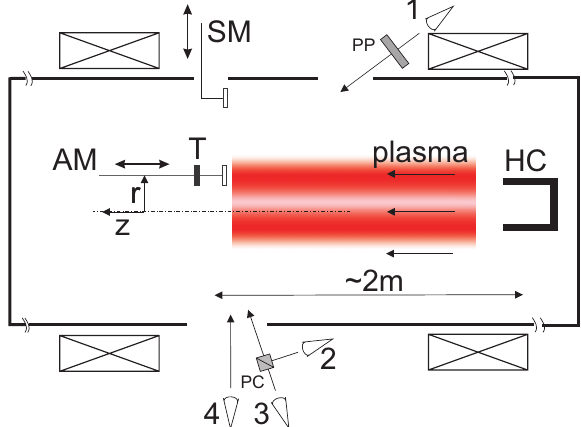
Figure 4. Top view of the optical emission measurements at the linear plasma PSI-2 [18]. Plasma is generated at the hollow cathode HC, and the target T is positioned in one of the maxima of the plasma profile using either the axial manipulator AM or the side manipulator SM. Line-of-Sight 1 observes the target at 35 ◦ ; Lines-of-Sight 2 and 3 observe the target at the angle of 70 ◦ and Line-of-sight 4 at the angle of 90 ◦ . For the polarization measurements, the polarization plate PP is installed at 1, and the polarization cube PC is used at Lines-of-Sight 2 and